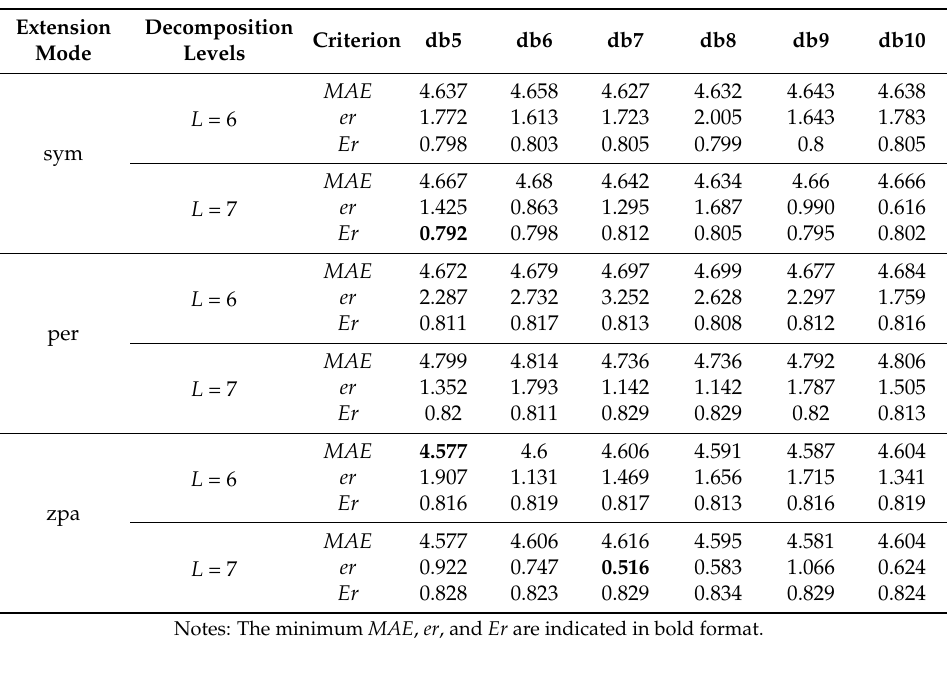
Table 2. MAE , er , and Er of monthly mean flow series (sym: symmetrization extension; per: periodic extension; zpa: zero-padding extension).